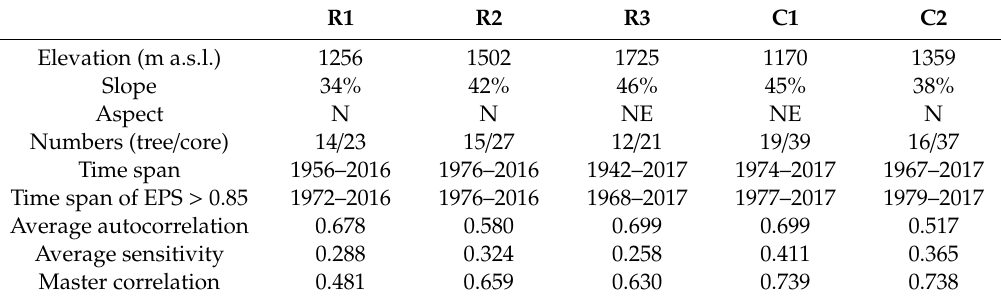
Table 1. Description of the sampling sites and tree ring width